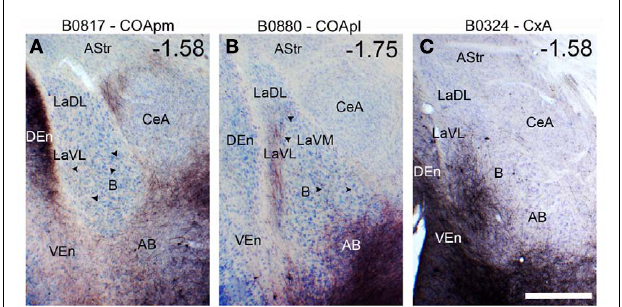
FIGURE 5 |Anterograde labeling in the multimodal amygdaloid nuclei following tracer injections in the chemosensory amygdala. (A) Dense anterograde labeling observed in the accessory basal nucleus of the amygdala following a BDA injection in the COApm, which is the main cortical target of vomeronasal information relayed by the AOB. A few scattered fibers are also present in the basal nucleus of the amygdala (arrowheads). (B) Anterograde labeling found in the basolateral complex of the amygdala after a BDA injection in the COApl. Note the band of labeled fibers in the lateral aspect of the B and the ventrolateral L. In addition, scattered fibers are observed throughout the B. (C) Anterograde labeling in the basolateral amygdaloid complex following a BDA injection centered in the CxA, which also affected a small portion of the neighboring COAa.Thre resulting anterograde labeling is especially dense in the lateral part of the B and AB, and extends into the ventrolateral L. For abbreviations, see list. Scale bar in (C) = 500 μ m, valid for the whole figure.The antero-posterior coordinate relative to Bregma is indicated in the upper right corner of each